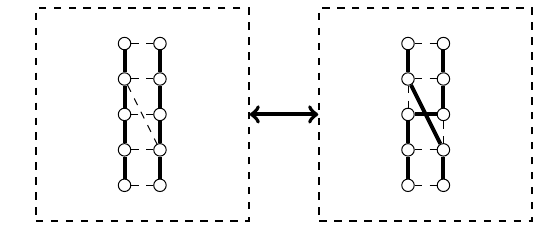
Figure 4. All the possible configurations of a Hamiltonian cycle passing through gadgets. The edges on the cycle are indicated by thick lines, but the ears are omitted; the edges out of the cycle are indicated by dotted lines. Each dotted square represents a possible configuration, and two squares are joined by an arrow if one is obtained from the other by a single